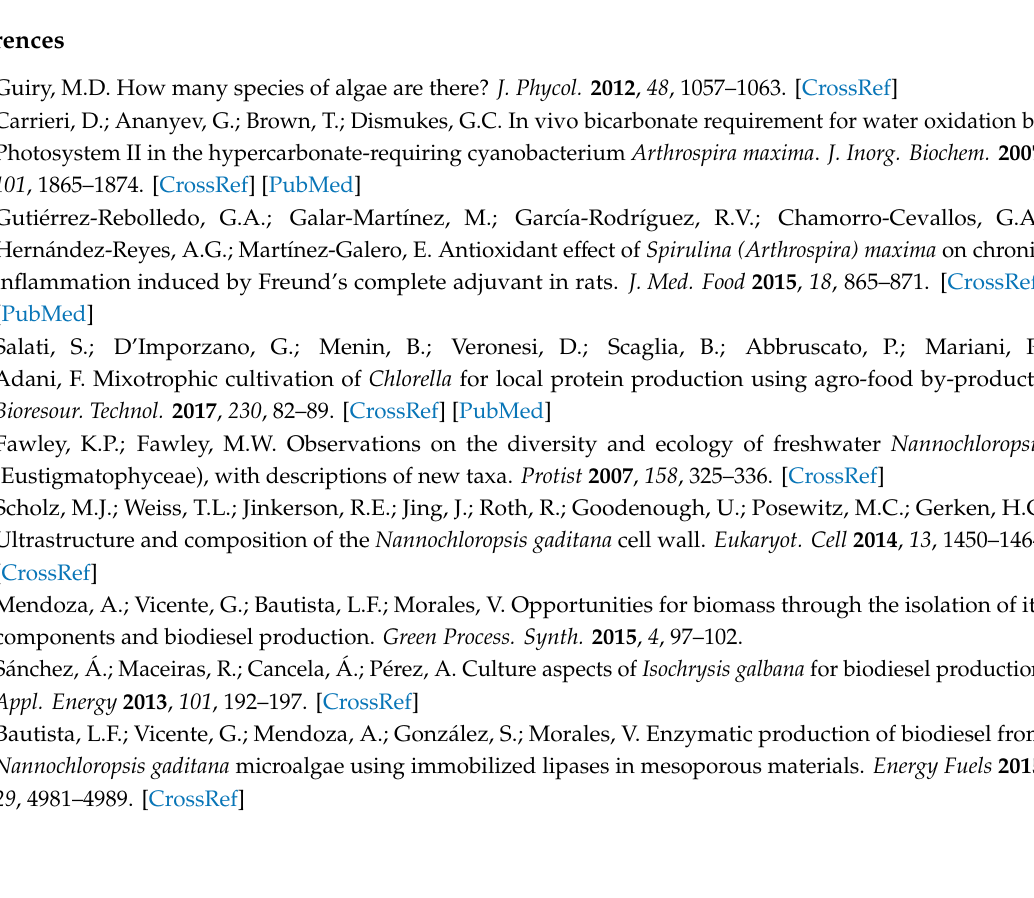
Supplementary Materials: The following are available online, Table S1. Composition of Guillard’s F / 2 and Walne’s media, Table S2: Elemental composition (%) of A. maxima at di ff erent times, Table S3: Elemental composition (%) of C. vulgaris at di ff erent times, Table S4: Elemental composition (%) of I. galbana at di ff erent times, Table S5: Elemental composition (%) of N. gaditana at di ff erent times, Table S6: Characterisation of water samples from wastewater treatment plant located at Campus of M ó stoles (Universidad Rey Juan Carlos), Table S7: Phosphorus depletion in wastewater AD2, Figure S1: Nitrate uptake in wastewater